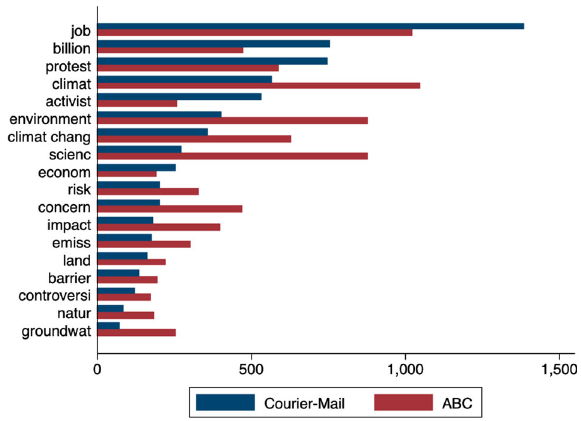
Fig. 1 Environmental topics and scienti fi c arguments are much more common in ABC than in Courier Mail, which is a corporate media outlet. Word count adjusted by the number of news articles and words per article, Source: